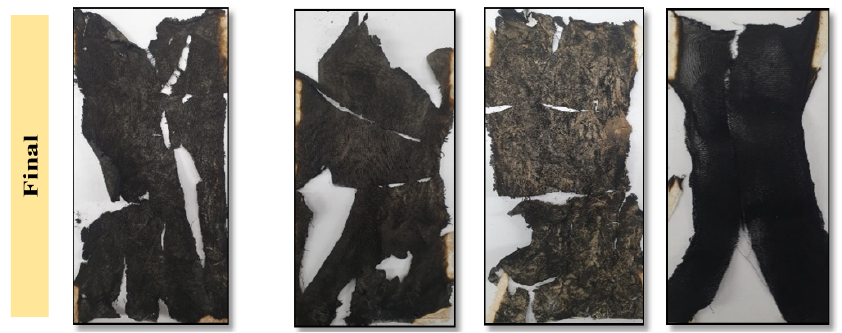
Figure 9. Final images of the coated sample completely converted to char as a result of VFT test.